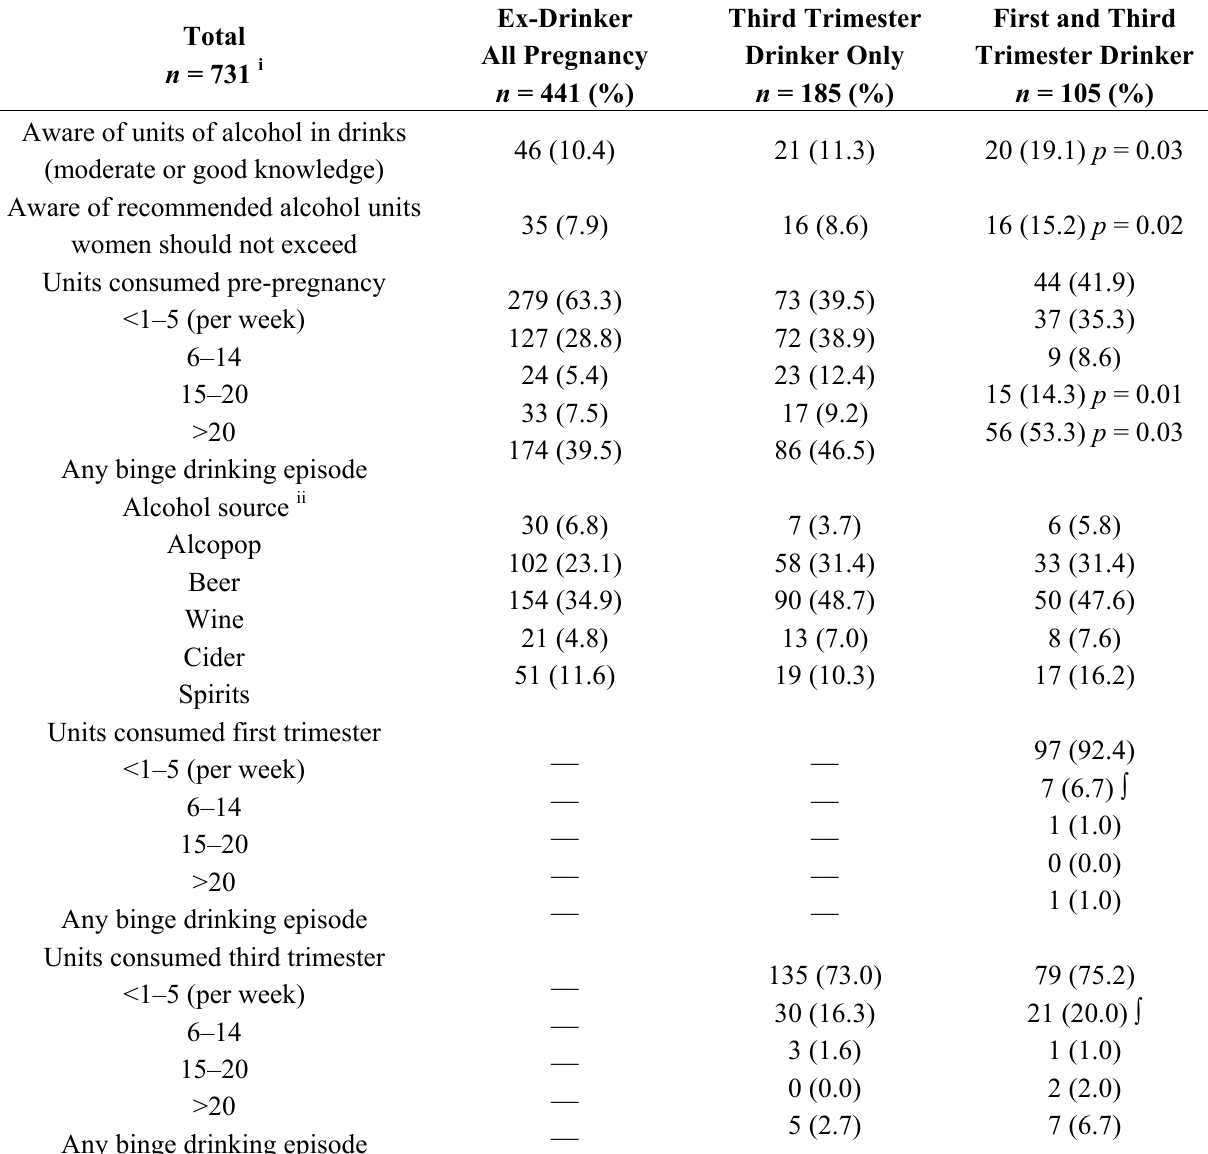
Ex-Drinker All Pregnancy